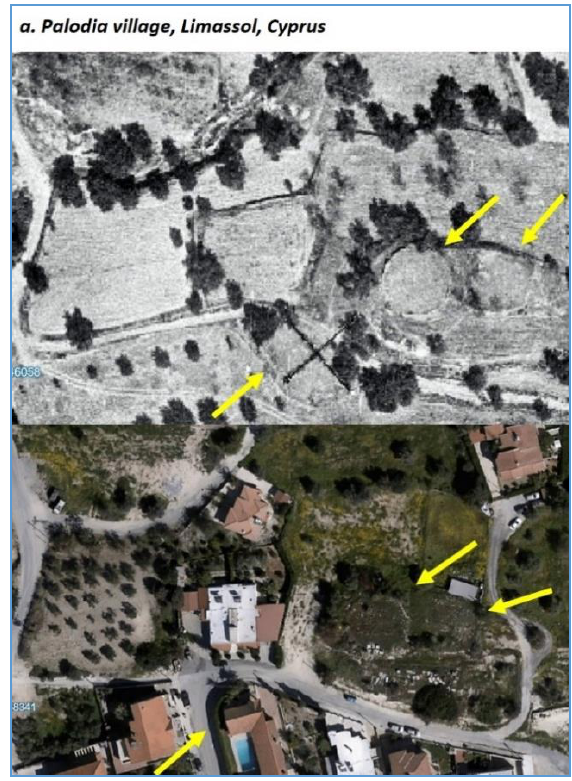
Figure 6. Threshing floors detected in Palodia village in 1963.